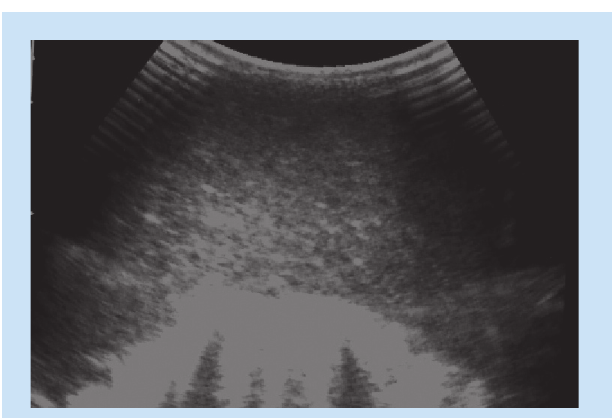
Fig. 2. Transverse section cut on abdominal ultrasound depicting echogenic material with a ‘snowstorm’ appearance.